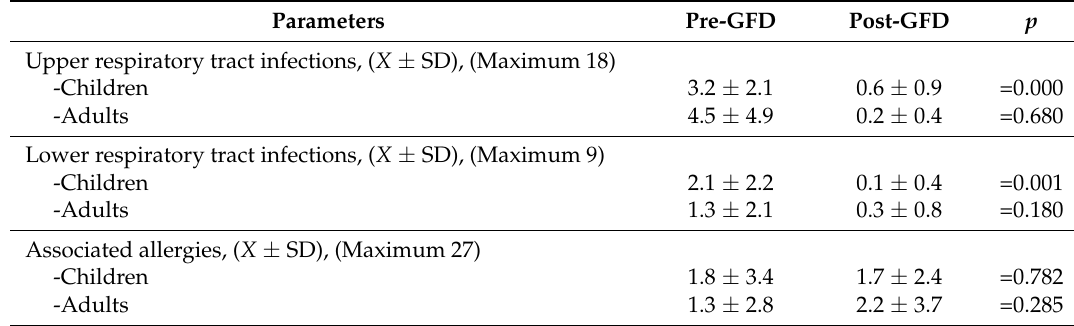
Table 5. Evolution of symptoms of non-coeliac gluten sensitivity after 1 year of a